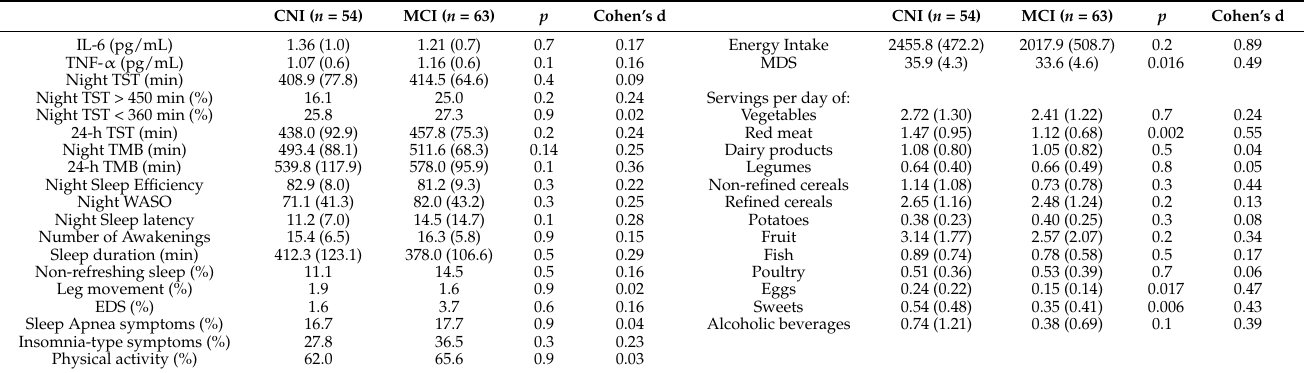
Table 3. Inflammatory Markers, diet, sleep, and physical activity by diagnostic